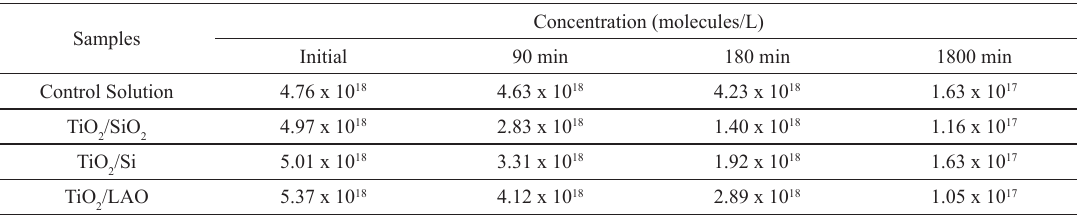
Figure 1. Absorbances as a function of the wavelength of methylene blue solutions taken at 0, 90, 180, and 1800 minutes, corresponding to the 13 th cycle of the irradiation stability tests. (a) Corresponding to the solution in the reactor containing the TiO Corresponding to the control solution in the reactor without Table 1. Comparison of the concentration in molecules/L on methylene blue solution for the reactor without photocatalyst and for reactors containing TiO /SiO , TiO /Si, and TiO /LAO as photocatalysts in the 13 th cycle of the material stability test. The results correspond to 2 2 2 2 UV irradiation of a mercury lamp, delivering 4.7 mW/cm 2 at the reactor position. Samples